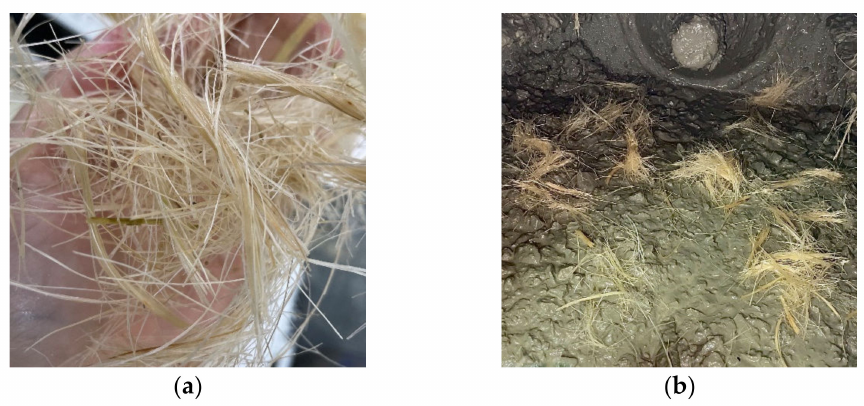
Figure 1. Sisal fibers ( a ) as received; ( b ) cut to length during mixing.